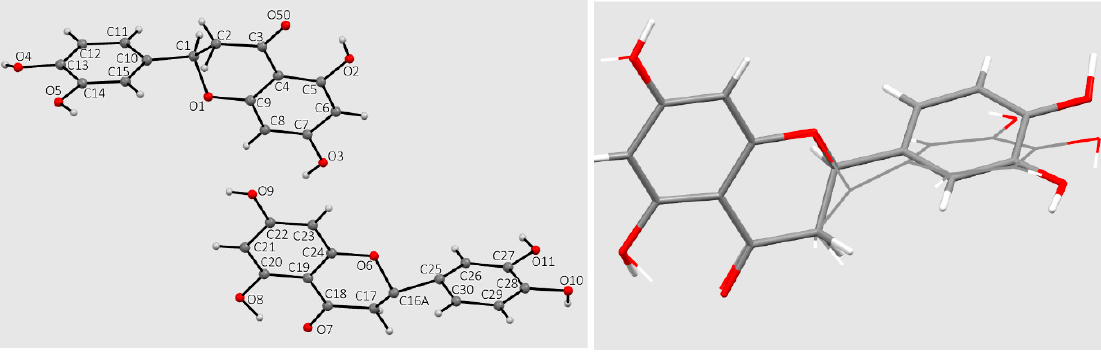
Figure 9. Atom labeling for non-H atoms in the 2 independent molecules. For clarity, disordered C atoms C1 and C16A not shown, left. Superposition of the 2 independent molecules of eriodictyol in the asymmetric unit, right. One molecule is in heavier stick mode while the second is narrower stick mode.